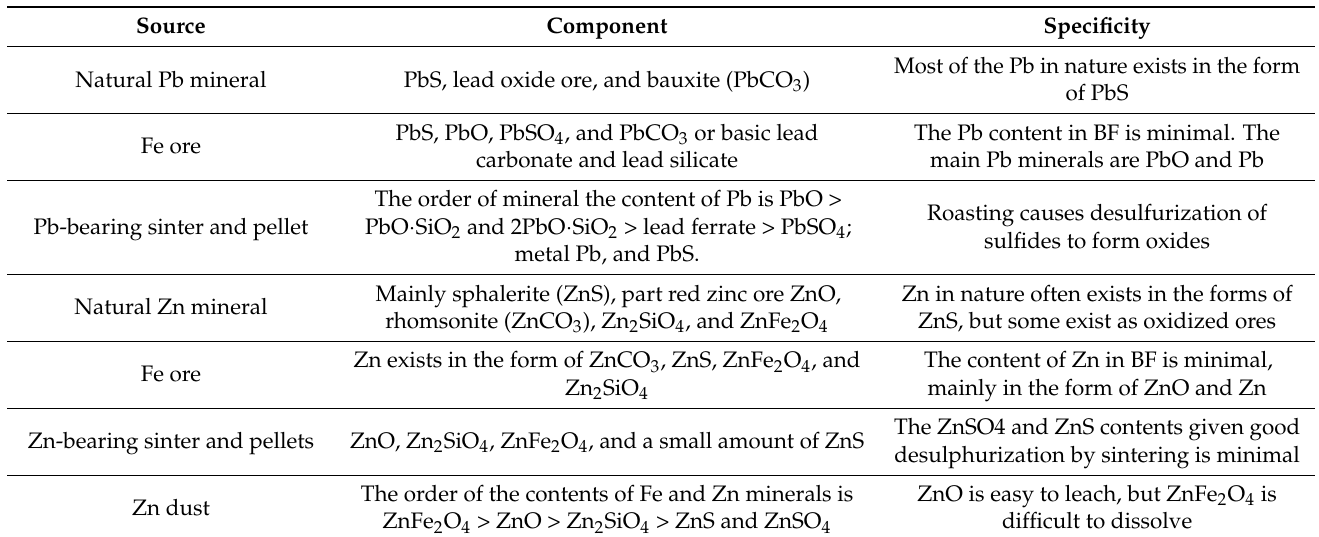
Table 2. Output and occurrence status of Pb and Zn